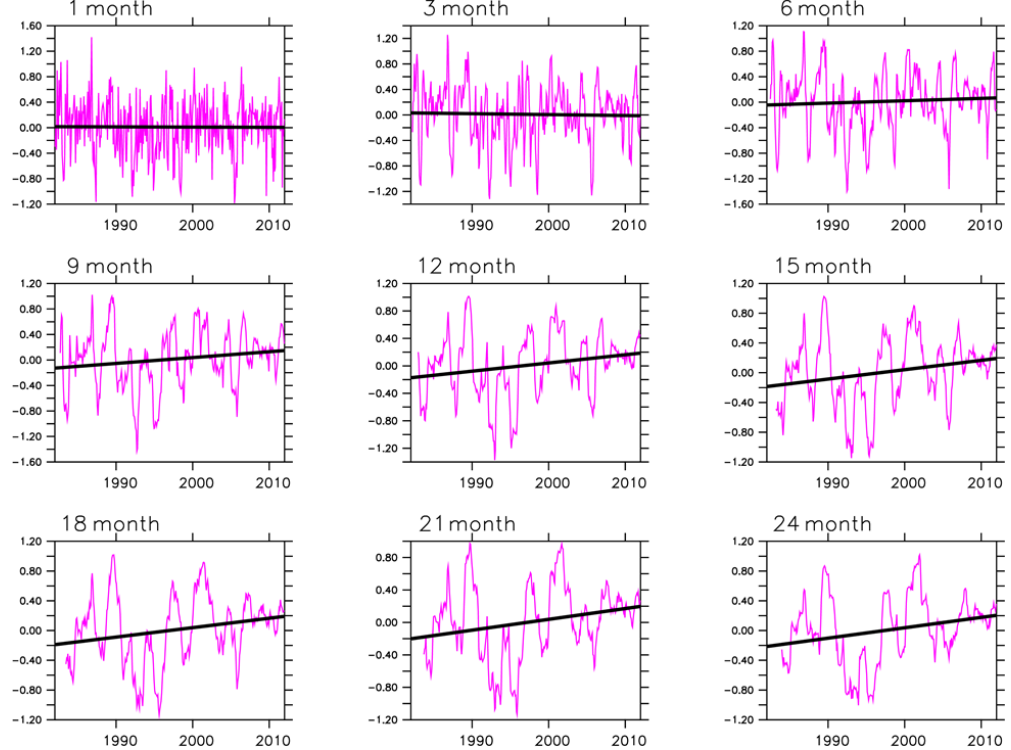
Figure 6. Evolution of SPEI in southern Africa for the period 1982–2011. The trend is significant at the 90% confidence interval for all